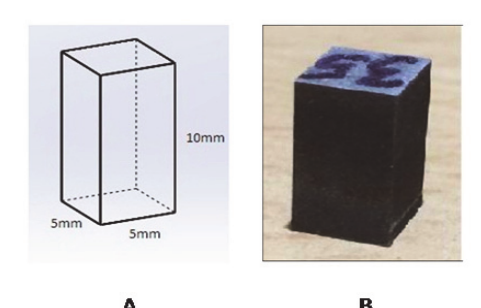
Fig. 2. Inconel 825 A) Actual dimensions of the specimen B) Image of the specimen after